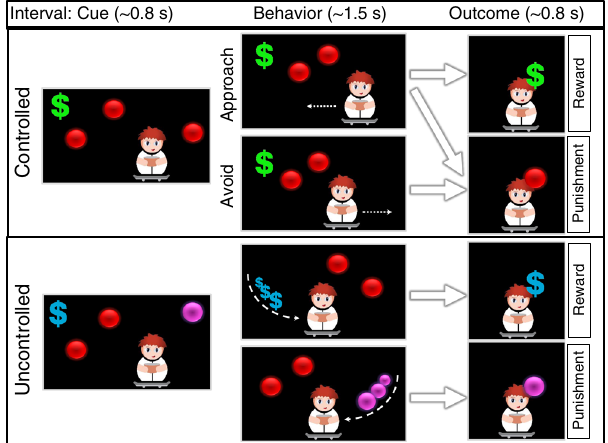
Fig. 1 The paradigm. The goal of the game was to earn virtual money by catching shekel signs and avoiding balls. A small avatar on a skateboard was located at the bottom of the screen and subjects had to move the avatar right and left using right and left arrow keys, in order to catch the money and avoid the balls falling from the top of the screen. There were two ways to gain or lose money — a “ controlled ” condition, where players actively approached green money signs (marked here as dollar signs) and avoided red balls, and an “ uncontrolled ” condition, where although cues appeared on the top of the screen (reward — cyan dollar sign, punishment — magenta ball), they always hit the avatar with no relation to the players ’ action (they chase the avatar during their fall). Each money catch resulted in a fi ve-point gain and each ball hit resulted in a loss of fi ve points, regardless of controllability (the outcome was shown on the screen after each trial). All four outcome event types occurred roughly at the same frequency, adaptive to the player ’ s behavior. Each money trial was separated by a jittered interstimulus interval (ISI), which varied randomly between 550 and 2050